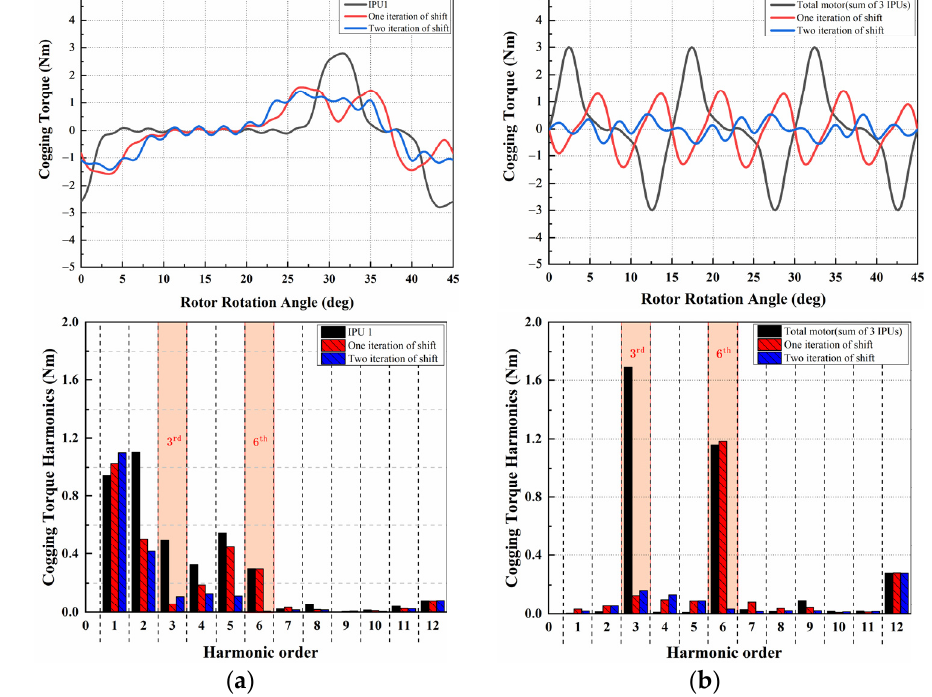
Figure 7. The cogging torque FEA pattern with FFT results: ( a ) the IPU1 and ( b ) the total motor.